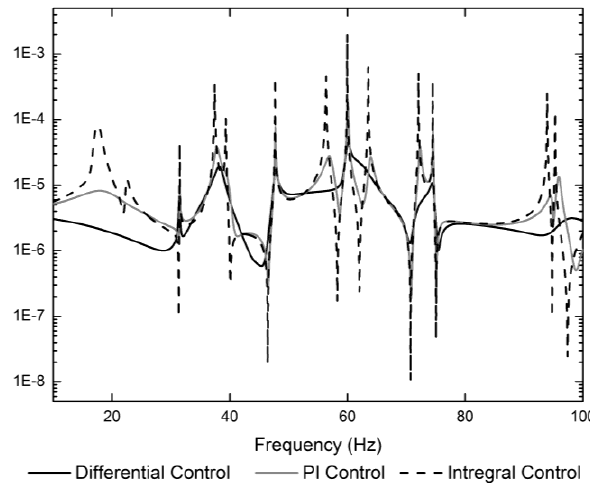
Figure 5. Frequency-response functions with three control strategies.